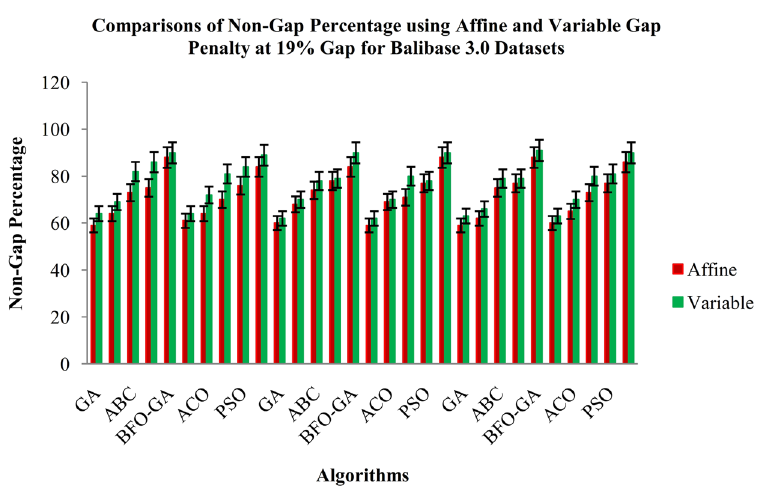
Figure 5. Comparisons of Non-Gap Percentage values for BAliBASE 3.0 datasets using Affine and Variable Gap penalty for the proposed and existing